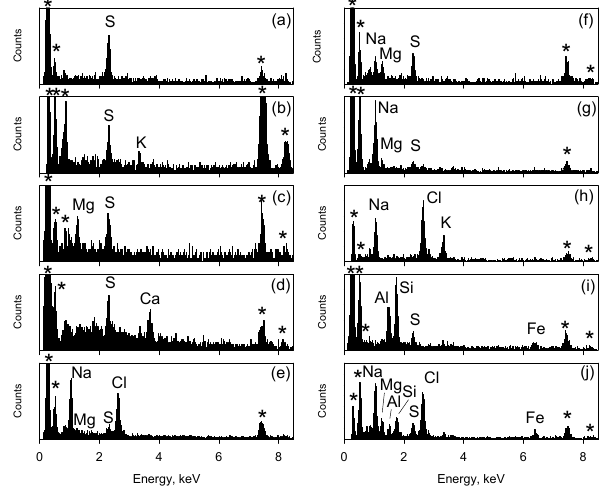
Figure 7. EDX spectra of aerosol particles collected during the JASE traverse. Asterisks denote background peaks derived from the sample